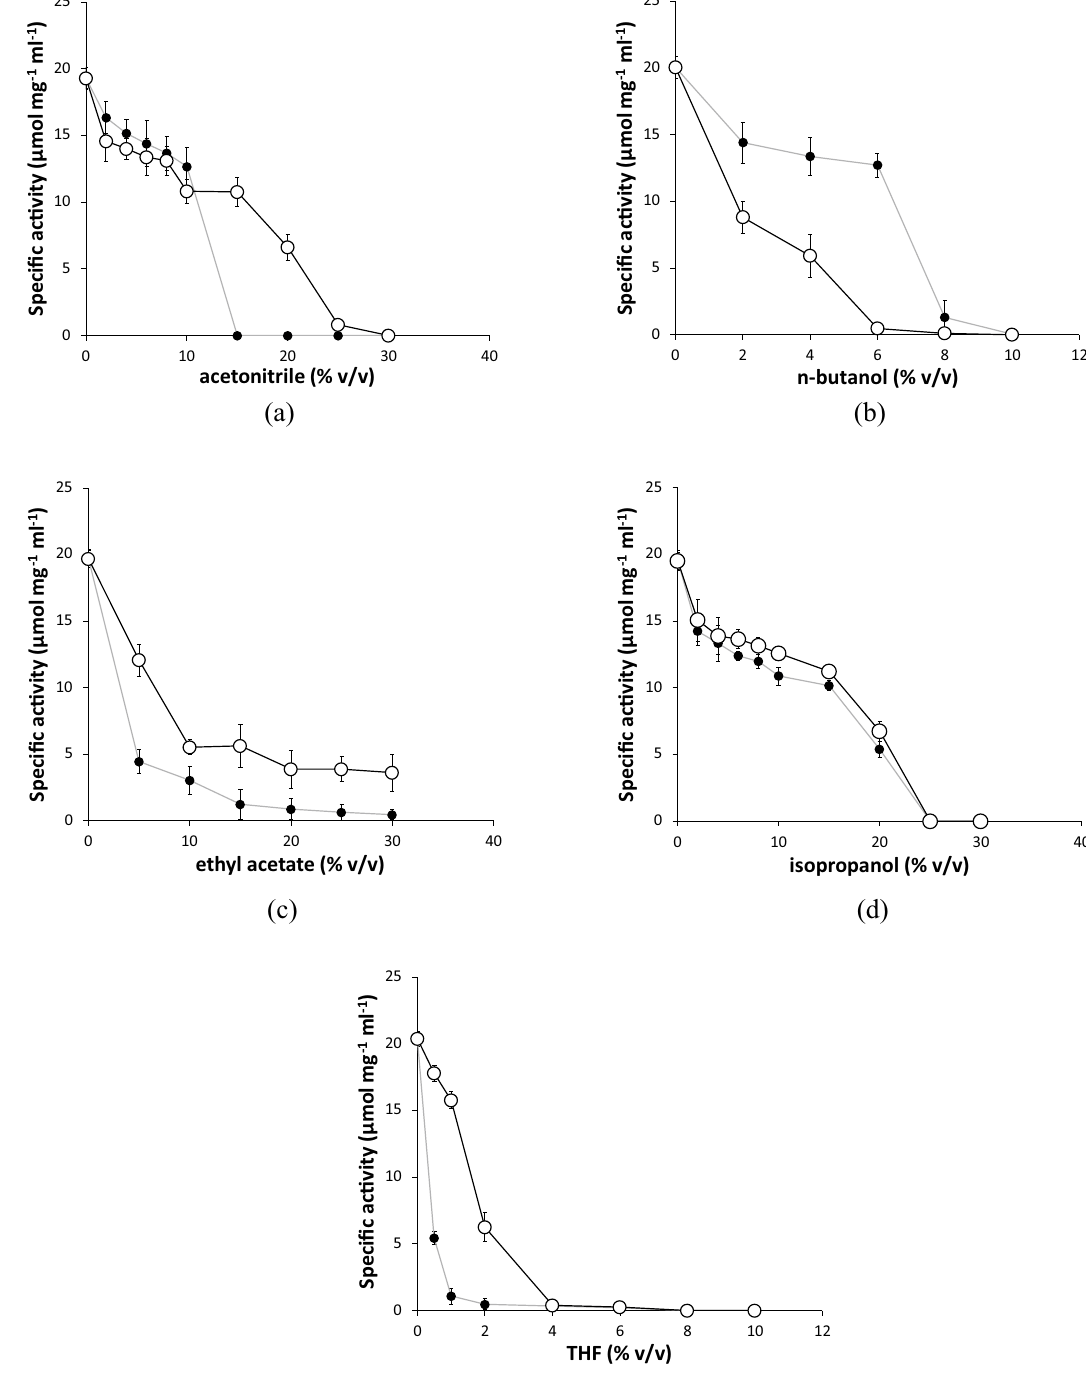
Figure 2. Retention of transketolase catalytic activity after pre-incubation with increasing concentrations of organic solvents. (open circle) Apo-TK and (filled circle) holo-TK were compared for their stability to incubation with ( a ) acetonitrile ( b ) n-butanol ( c ) ethyl acetate ( d ) isopropanol ( e ) THF, in 50 mM Tris–HCl, pH 7.0 (plus 4.8 mM TPP, 18 mM MgCl 2 for holo-TK), for 3 h at 25 °C and 1000 rpm shaking. Enzyme activity was measured after a 20-fold dilution of the solvents, at 50 mM HPA and 50 mM GA in 2.4 mM TPP, 9 mM MgCl 2 , 50 mM Tris–HCl, pH